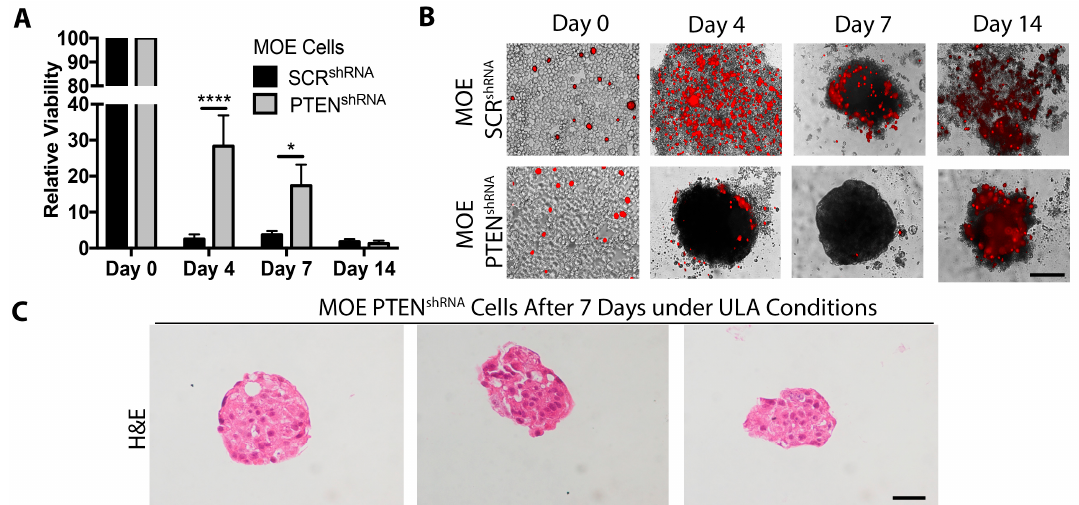
Figure 4. MOE PTEN shRNA MTS survive better under ULA conditions. ( A ) Relative viability of MOE SCR shRNA and MOE PTEN shRNA cells cultured under ULA conditions for 0, 4, 7, and 14 days. Analyzed by two-way ANOVA and Sidak’s multiple comparison test. Data are presented as mean ± SEM. n = 4. Significantly different as indicated, * p < 0.05; *** p < 0.001. ( B ) Representative overlay images showing cell membrane integrity, via propidium iodide (PI) staining, of cells and MTS in ULA culture for 0, 4, 7, and 14 days. n = 4. ( C ) hematoxylin and eosin (H&E) staining of MOE PTEN shRNA MTS after seven days under ULA conditions. n = 4. Scale bar= 100 μ m.